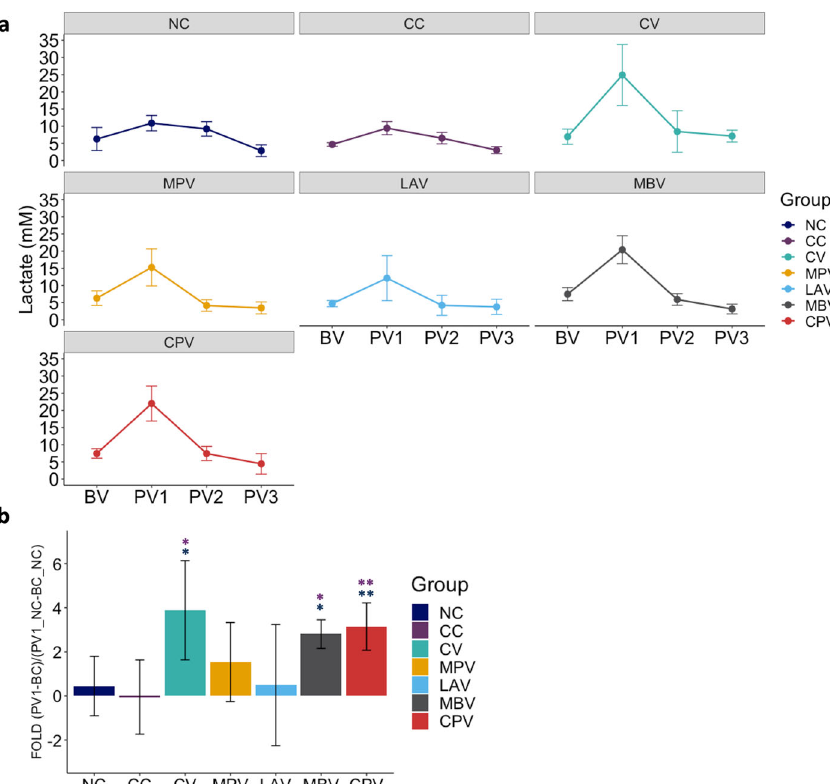
Fig. 5 Lactate levels in plasma. a Lactate level changes in plasma throughout sampling points. b Lactate level increase of vaccinated groups with respect to NC during the period between PV1 (1 month after fi rst dose vaccination) and BV (before vaccination). Blue asterisks represent signi fi cant differences between vaccinated or challenged groups with NC and purple asterisks represent signi fi cant differences between vaccinated groups and CC. All values were means with error bars representing standard deviation from groups of n = 5, except for NC which was n = 4. Kruskal – Wallis with Dunn ’ s post-hoc test was applied and signi fi cation levels are * p < 0.05, ** p <